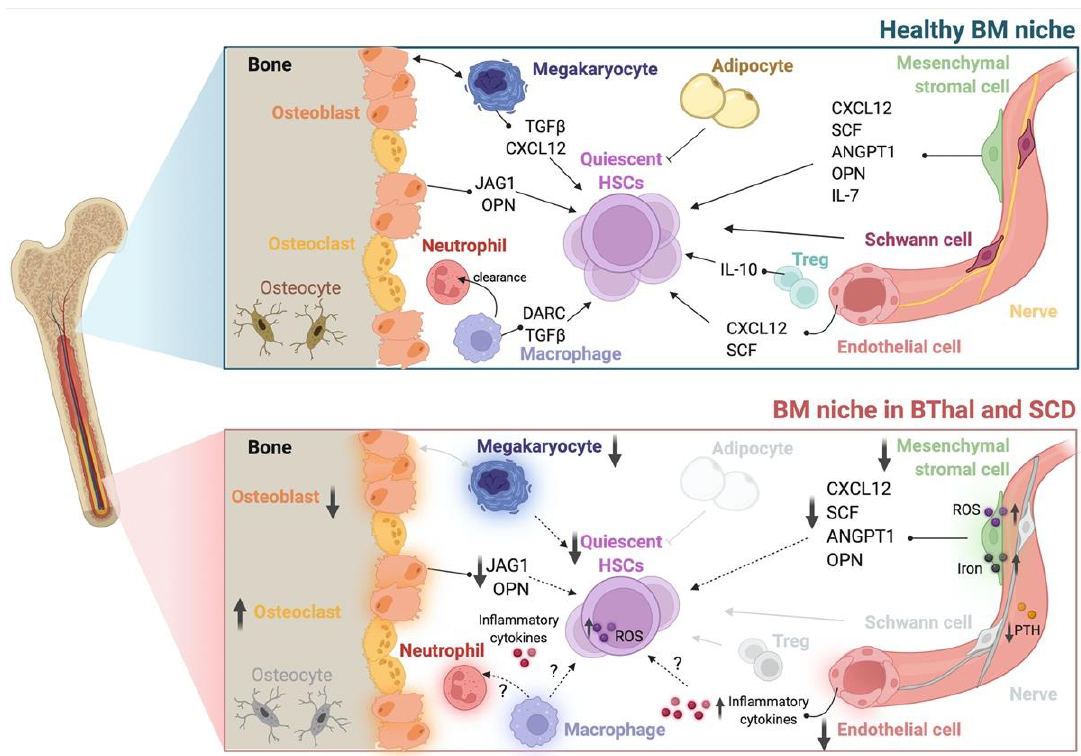
Figure 1. The BM HSC niche in healthy conditions and in BThal and SCD. Schematic representation of the adult BM niche in homeostasis, showing different stromal (osteoblasts, mesenchymal stromal cells, endothelial cells, Schwann cells, nerve fibers, and adipocytes) and hematopoietic (megakaryocytes, osteoclasts, macrophages, neutrophils, and Tregs) cell types and niche factors that regulate HSC quiescence and function ( upper panel ). The BM niche in BThal and SCD shows alterations in BM osteolineage cells, mesenchymal stromal cells, endothelial cells, and megakaryocytes, causing the reduced production of niche molecules supporting HSC activity. The accumulation of ROS, iron, and inflammatory cytokines contributes to the impairment of HSC maintenance ( bottom panel ). Created with